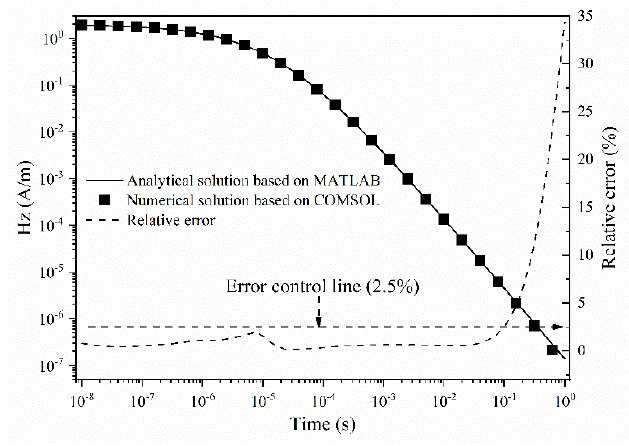
Figure 8. Calculation results and relative error of two methods.